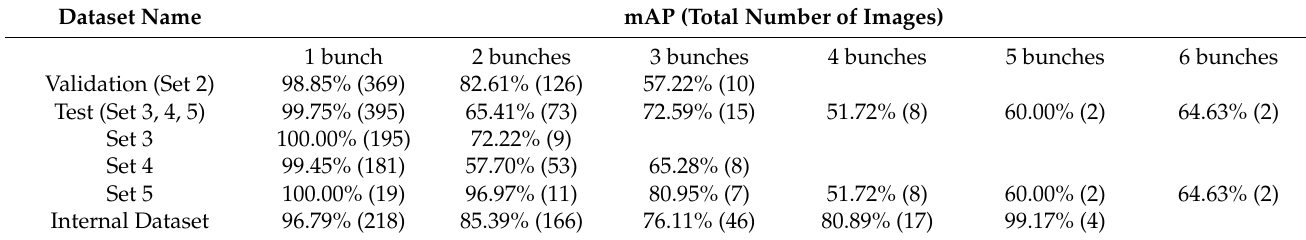
Table 5. Experimental results on both GrapeCS-ML and our internal dataset based on the number of bunches present in the images. After each mAP value, in brackets, the number of examined images is